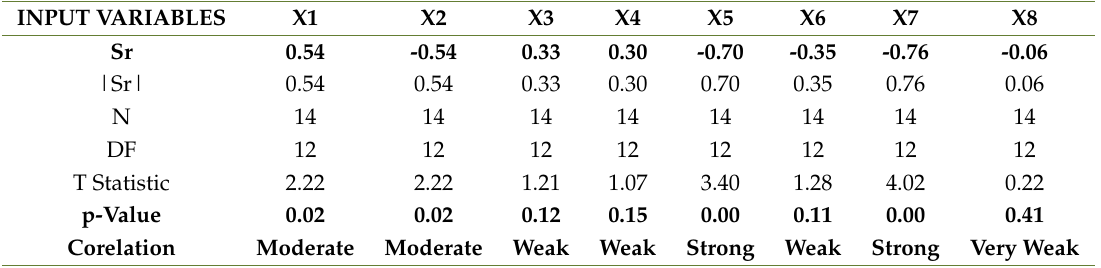
Table 7. The Spearman correlation and its